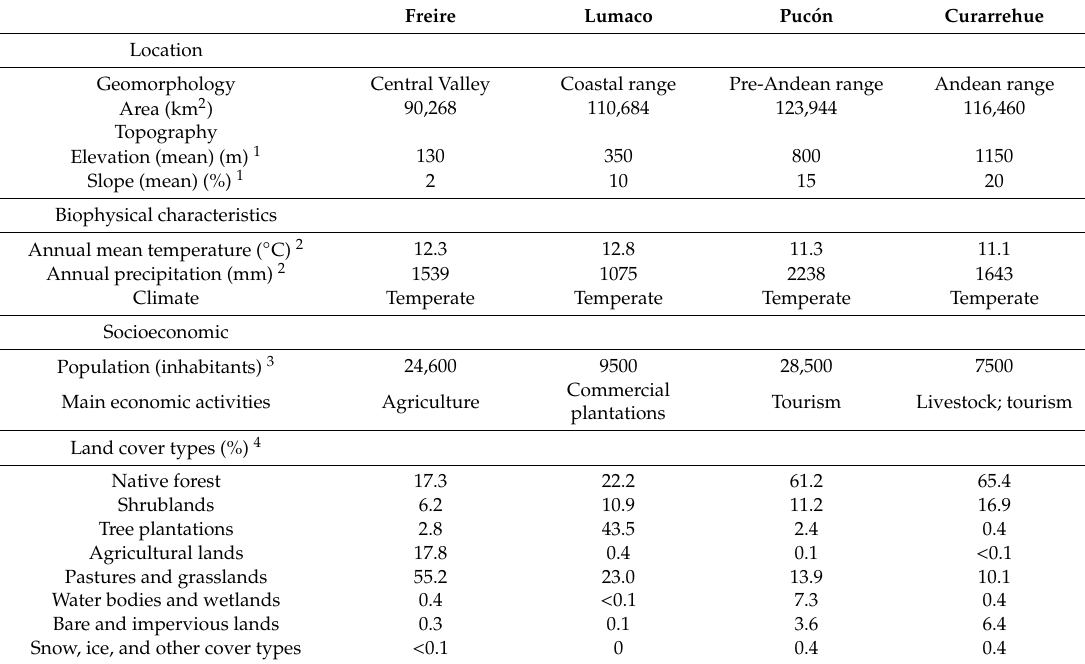
Table 1. Characteristics of four landscapes in the La Araucanía Region, south-central Chile. Freire